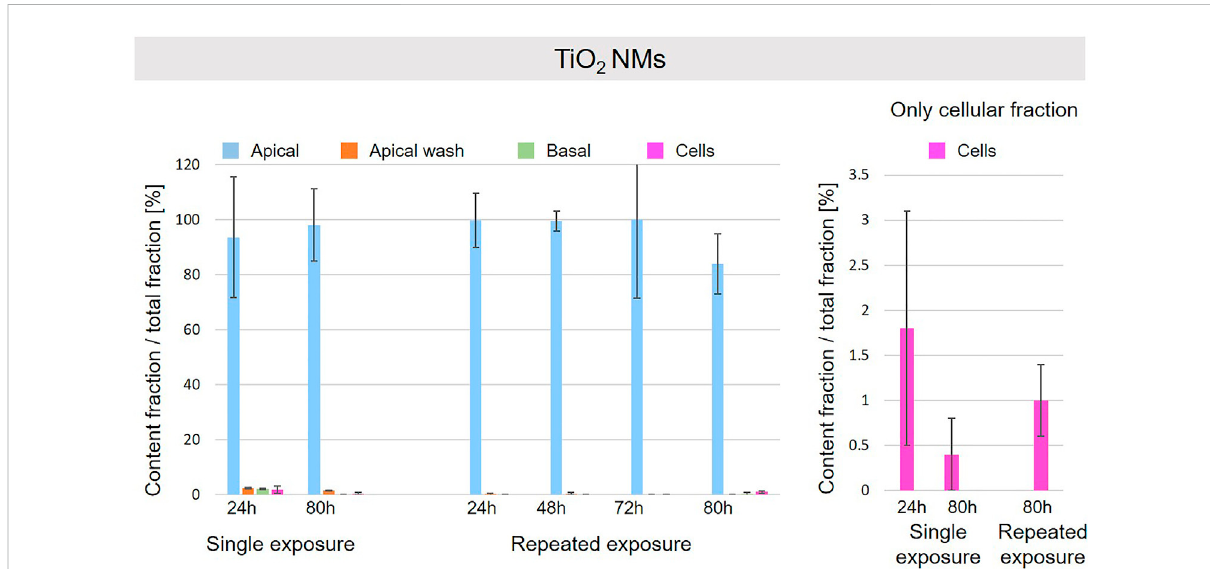
FIGURE 7 Fate of TiO 2 NMs attheA549 tissuebarrier after single and repeated exposures. For single exposures TiO 2 NMs wasexposedat aconcentration of 100 µg/ml and the different fractions were collected after incubation for 24 and 80 h. For repeated exposures the cells were exposed repeatedly every day up to 80 h, using 25 µg/ml TiO 2 NMs concentration, resulting in a total exposure of 100 µg/ml and 80 h incubation time in total. Apical, apicalcellwashandbasalsampleswerecollectedafter24,48,72,and80 hofexposure.Rightside: Thisgraphonlydepictsthecellularfraction. A total of three independent experiments ( n = 3), with three single replicates each, were performed.